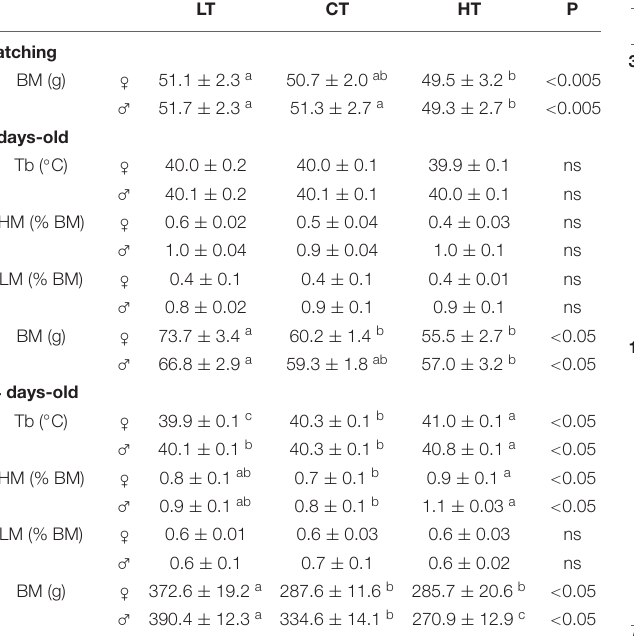
TABLE 2 | Values of ventilation ( ˙ V E ), tidal volume (V T ), respiratory frequency (f R ), oxygen consumption ( ˙ VO 2 ), and ventilatory equivalent ( ˙ V E / ˙ VO 2 ) of 3 and 14 days-old female and male chickens that were incubated at control (CT; 37.5 ◦ C) or at higher (HT; 39 ◦ C) or lower (LT; 36 ◦ C) temperatures during 6 h/day, from day 0 to 5 of